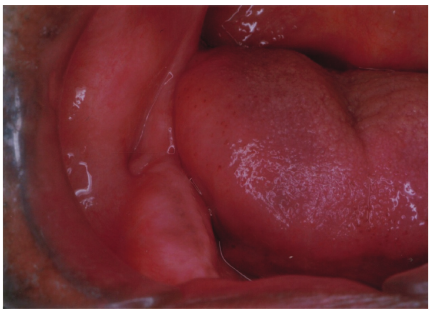
Figure 2: Postsurgical depression due to dentigerous cyst enucle- ation at third molar